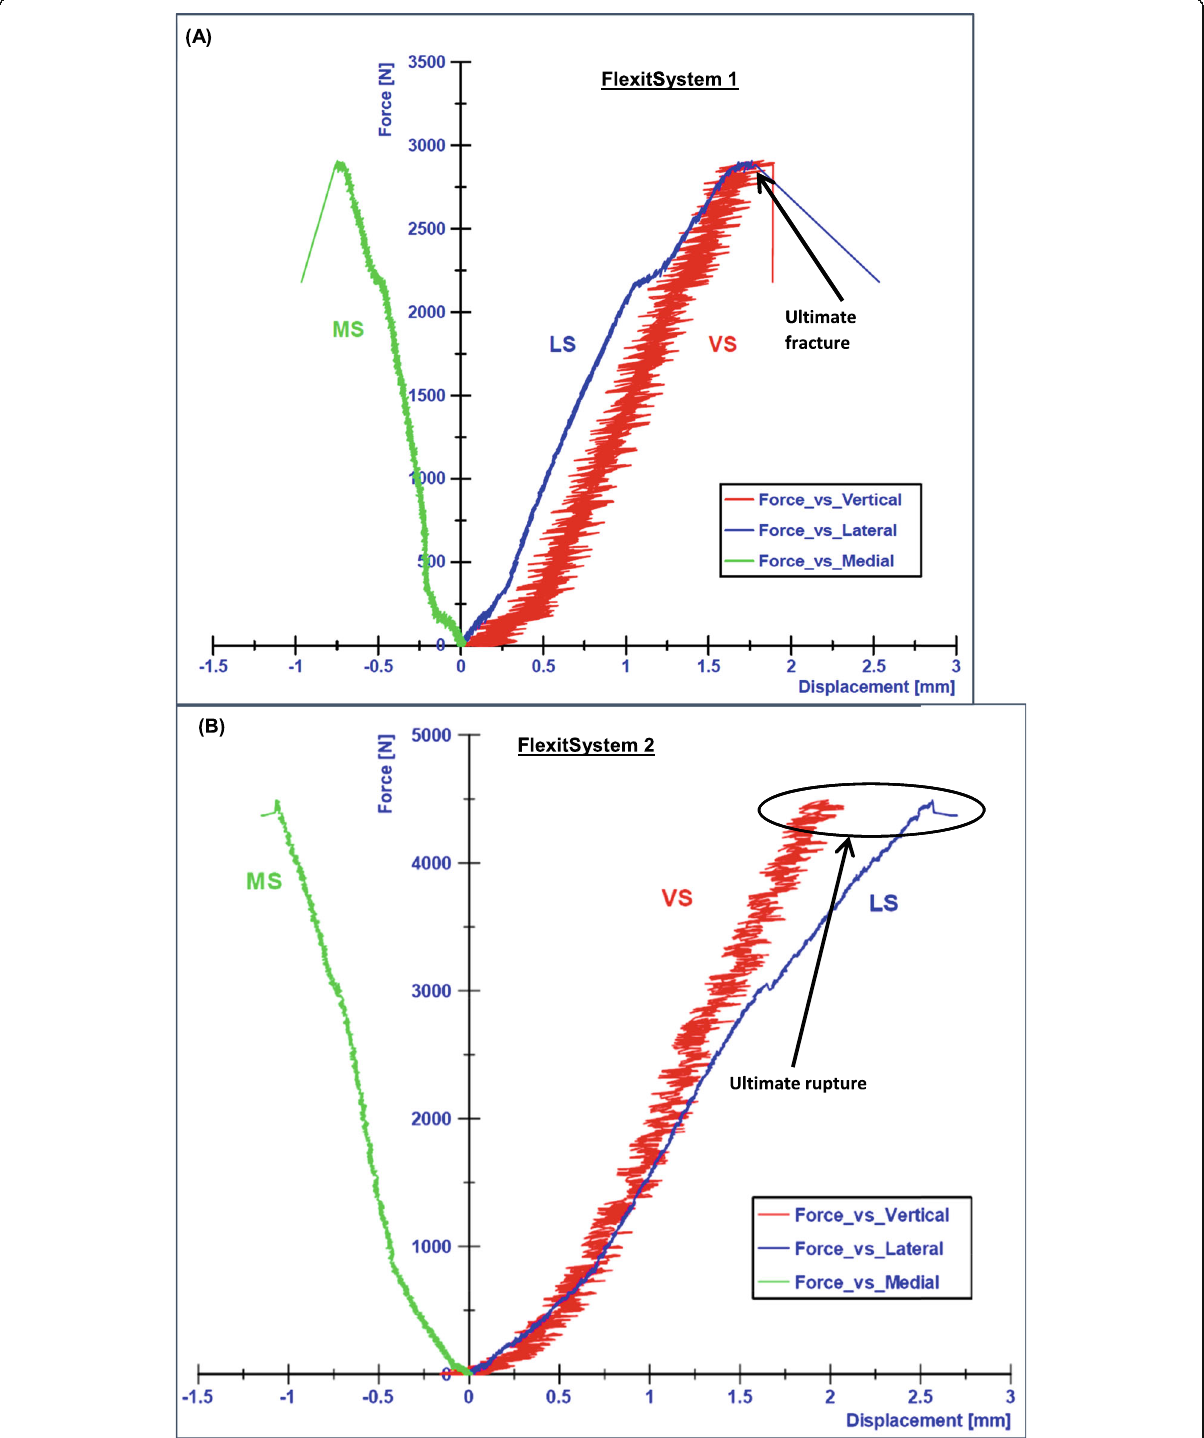
Fig. 4 Static test results: a FlexitSystem 1, b FlexitSystem 2. The ultimate loads were considered as the approximate loads at the moment of collapse of the contralateral cortex